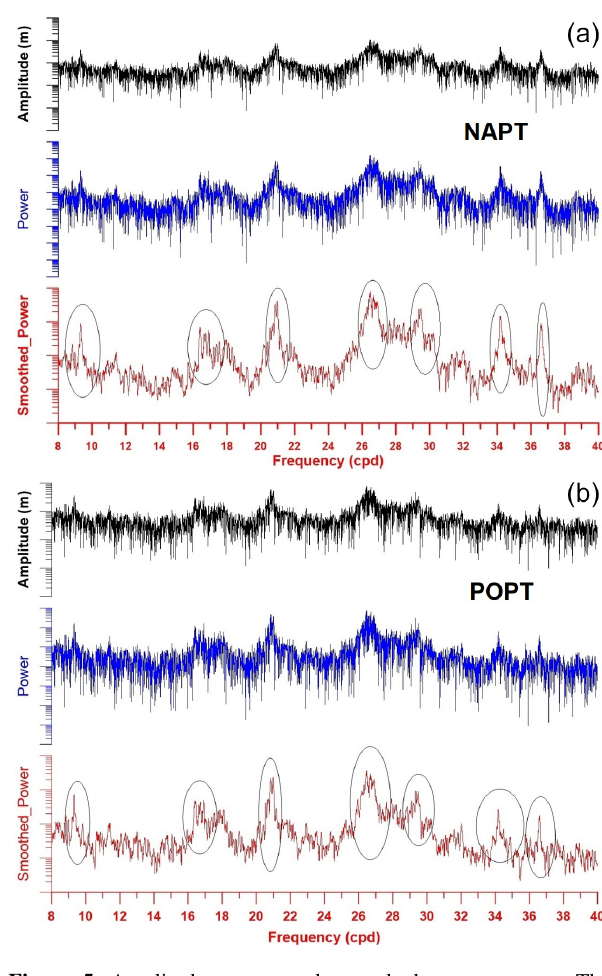
Figure 5. Amplitude, power and smoothed power spectra. The black ellipses contain the frequency range of the seven seiches be- tween 8 and 40 cpd for NAPT (a) and POPT (b) tide gauge